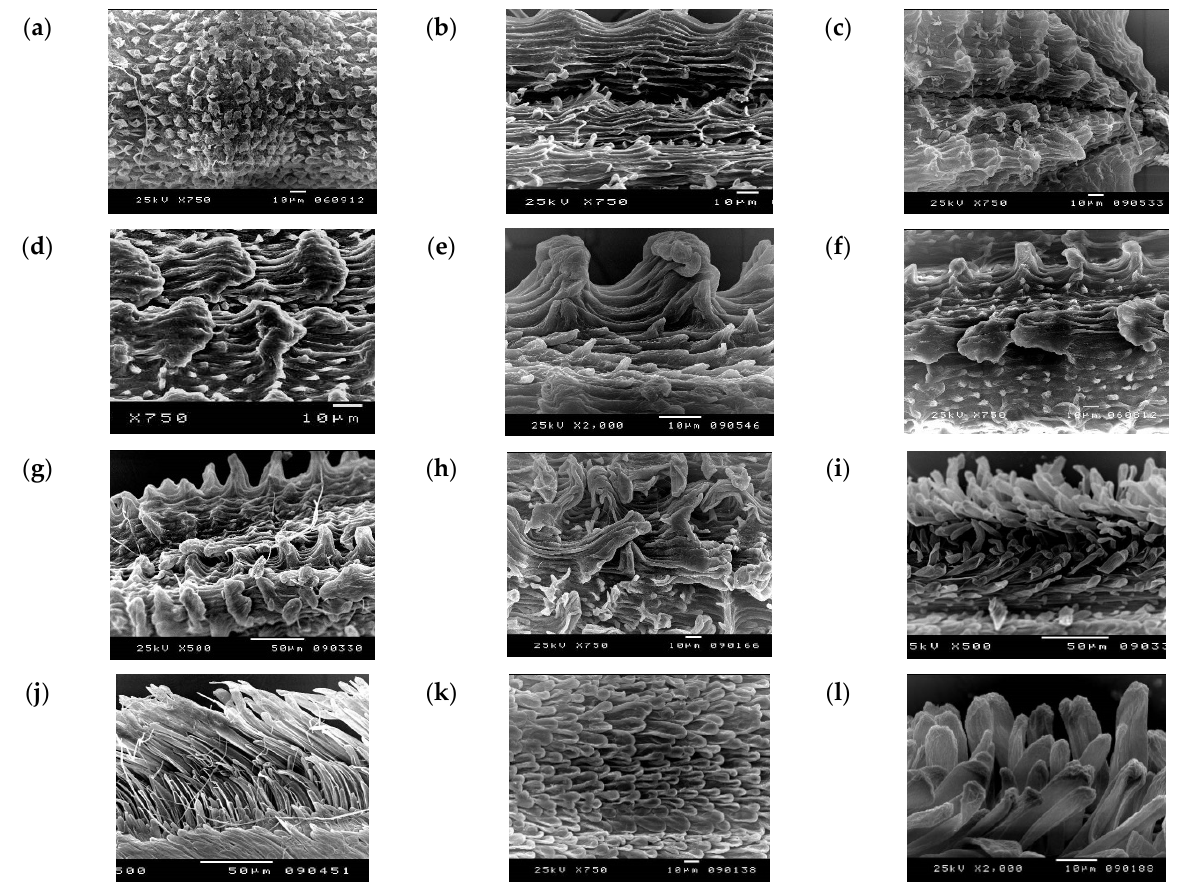
Figure 5. SEM micrographs of marginal achenes. ( a ) Reichardia tingitana , coarse-verrucate transversely rugose surface. ( b – l ) Launaea , wrinkled surface: ( b ) L. spinosa , short squarrose with rounded apex, elongated adjusted epidermal cells with long rounded projections; ( c ) L. capitata , short squarrose with acute apex, elongated adjusted epidermal cells with short rounded projections; ( d ) L. intybacea and ( e ) L. massauensis , long recurved with acute apex, diffused epidermal cells with long acuminate projections; ( f , g ) L. nudicaulis (group 6), long incurved or recurved with acute apex, nearly adjusted elongated epidermal cells with short acute projections; ( h ) L. nudicaulis (group 7), long squarrose with acute apex, nearly adjusted elongated epidermal cells with long acuminate projections. ( i – l ) Launaea , papillose surface: ( i ) L. angustifolia subsp. angustifolia , long and linear unconnate papillae; ( j ) L. angustifolia subsp. arabica , long and linear connate papillae forming hyaline wing; ( k ) L. fragilis subsp. fragilis and ( l ) L. mucronata subsp. cassiniana , short and clavate papillae.